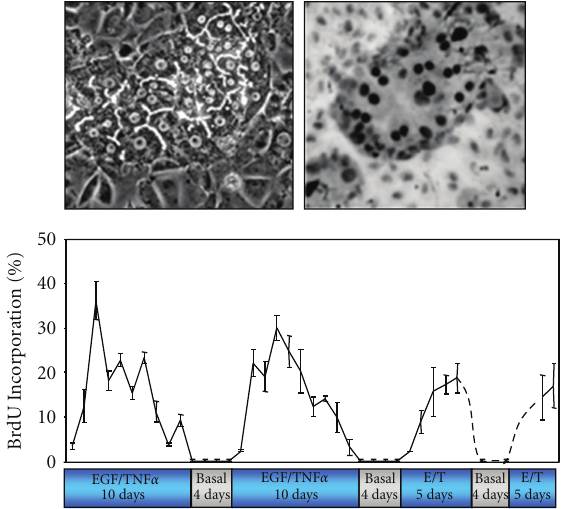
Figure 3: Proliferation of rat hepatocytes in coculture. Upper left: phase contrast picture of a colony of rat hepatocytes surrounded by Rat Liver Epithelia Cells (RLECs). Upper right: indirect immunode- tection of BrdU positive hepatocytes evidencing DNA replication within the hepatocyte colony. Chart: multiple waves of replication in hepatocytes maintained in coculture over 52 days. Four periods of stimulation using EGF and TNF α (E/T) were separated by culturing the cells in basal medium lacking the mitogenic cocktail. The BrdU was incorporated for 24h and at each time point triplicate cultures were fixed and stained for BrdU